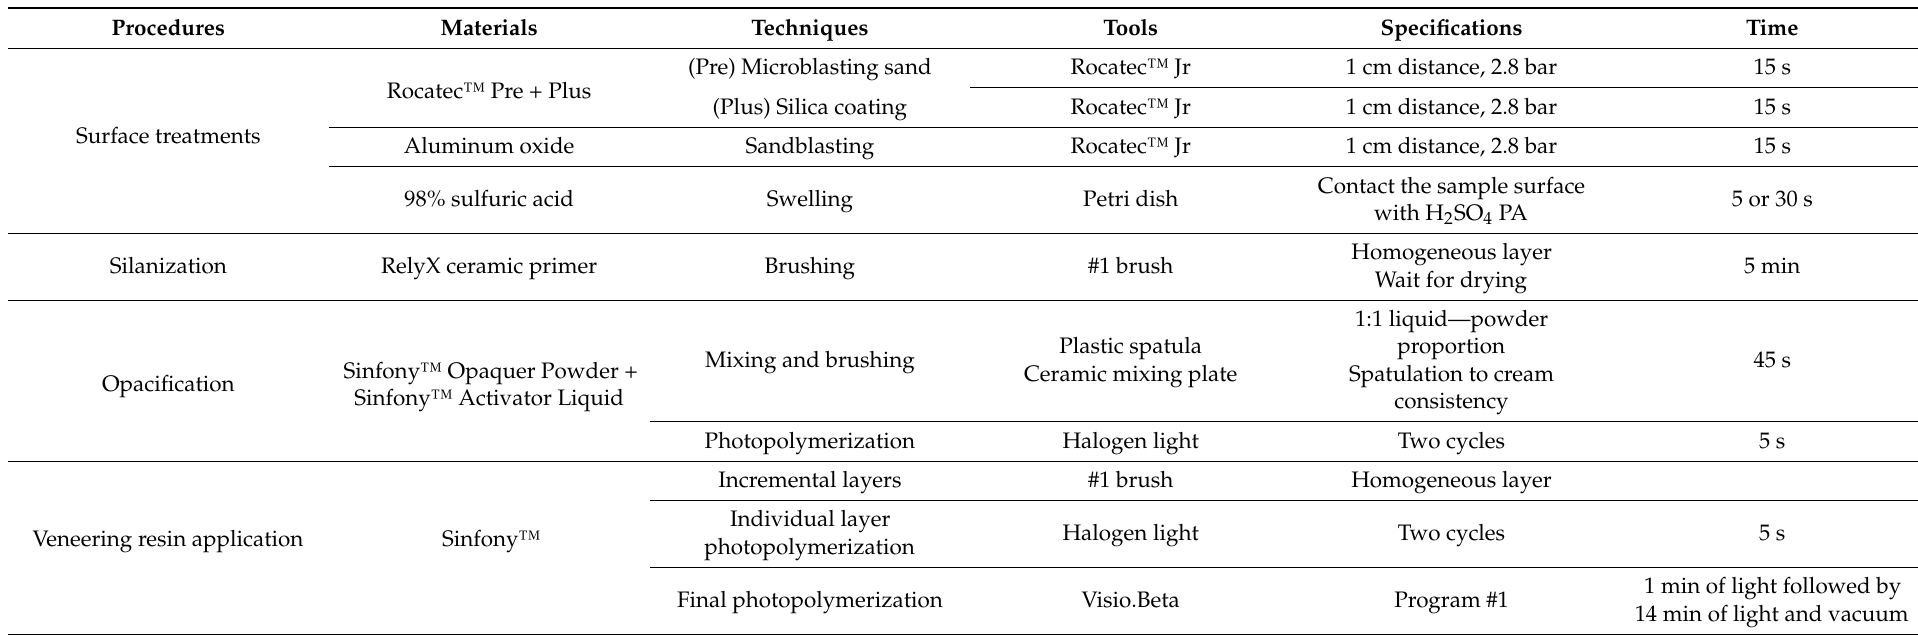
Table 2. Procedures related to surface treatments and sample preparation for shear bond